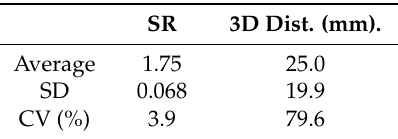
Figure 7. Precision analysis patch-scale models showing the spatial distribution of error (average distance, mm) among all replicate models. Table 4. Summary of patch-level precision analysis giving the average and SD surface rugosity (SR) values derived from the three replicate models as well as the average, SD, and CV (%) of the 3D distance (mm) between those models from comparisons of